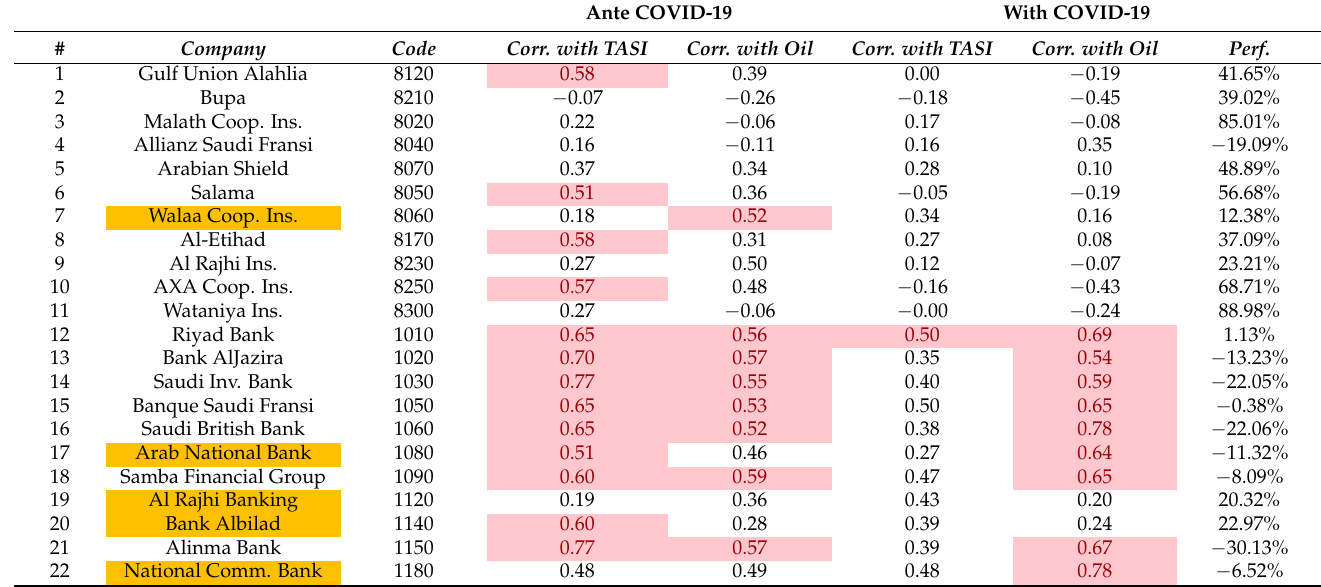
Table 4. Kendall correlations for insurances and banks next to performances (from the beginning of January 2019 to end of January 2021). Ante COVID-19 With